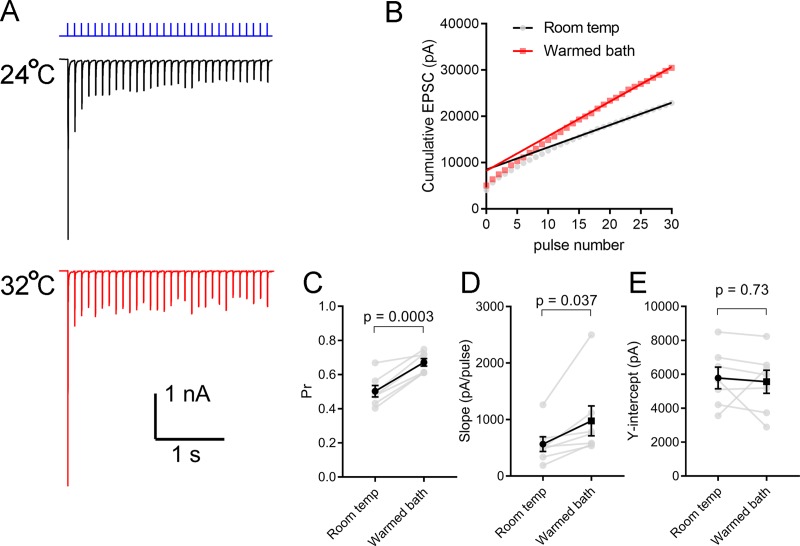
Temperature regulates synaptic vesicle release probability and replenishment at retinogeniculate synapses.A) Voltage-clamp recordings from a dLGN TC neuron EPSCs in response to a 10 Hz stimulation of retinal ganglion cell axons using a 460 nm LED in a brain slice from a Chx10-Cre;Ai32 mouse. Recordings were made in the presence of γDGG (200 μM) and cyclothiazide (100 μM). Each trace is the average of 3–5 individual responses to the same stimulus. B) Plot of cumulative EPSC amplitude and linear fit to the responses at pulses 15–30. Extrapolation to the Y-intercept is used as a measure of vesicle pool size while the slope is a measure of replenishment rate. Release probability is calculated as the ratio of the first EPSC to the Y-intercept. C) Vesicle release probability increased with warming the bath solution (n = 7 TC neuron recordings). D) Vesicle pool replenishment rate (slope of the fit in panel B) also increased with warming. E) The Y-intercept, which is a measure of vesicle pool size was not changed by warming.